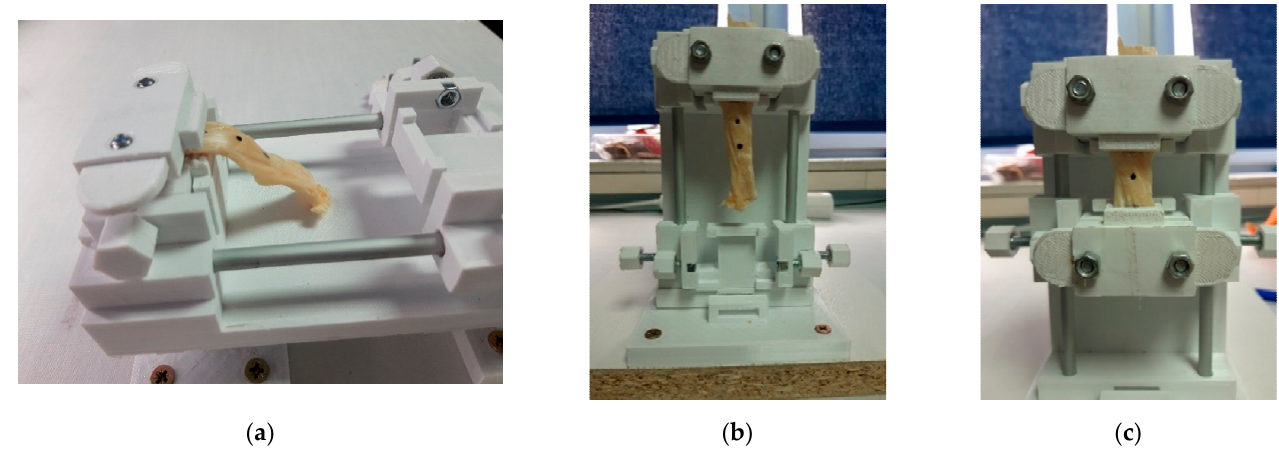
Figure 12. The specimen preparation using calibration device: ( a ) specimen in the upper clamps in the horizontal position; ( b ) vertical position of the calibrator with the specimen relaxing downwards; ( c ) the specimen–clamps assembly in the calibrator.